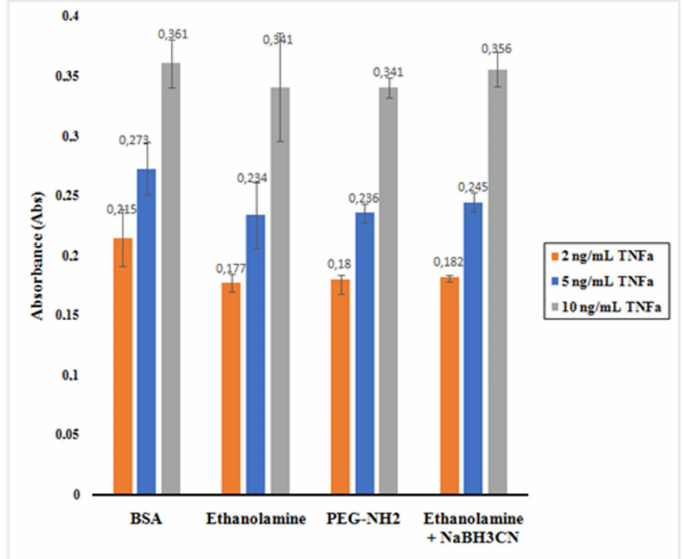
Figure 10. Impact of di ff erent deactivation mixtures (BSA, ethanolamine, PEG-NH 2 , ethanolamine + NaBH 3 CN) to the physisorption e ff ect of TNF- α on 3D nano-collector MNP@SiO 2 -NH 2 -CO-anti-TNF- α . Error bars correspond to three replicates per